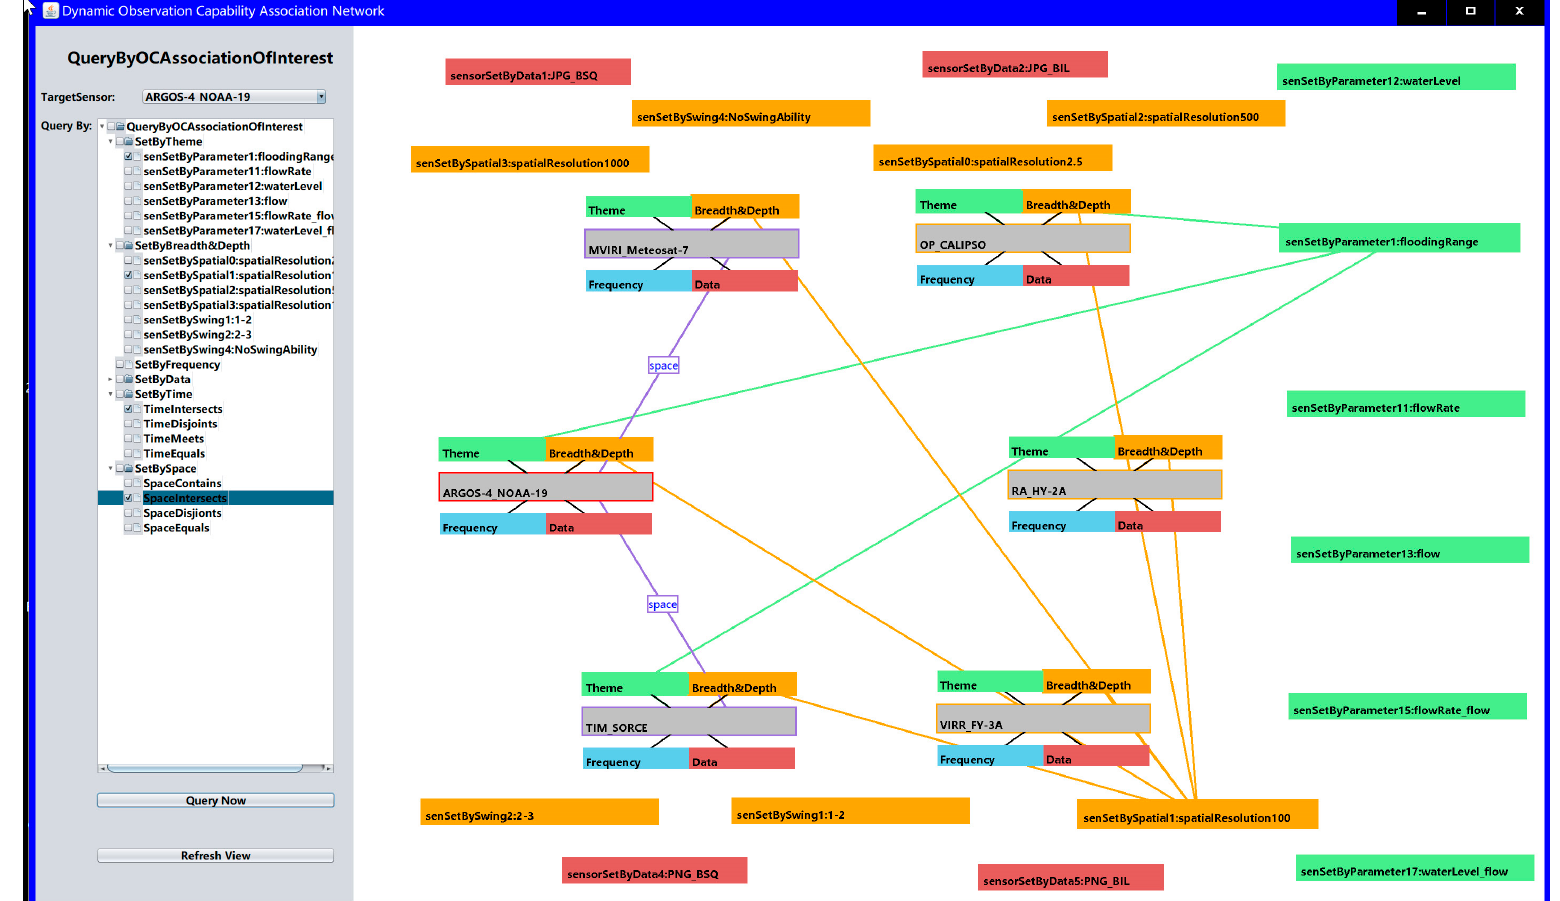
Figure 15. Supporting the retrieval of sensors and sensor associations of interest.